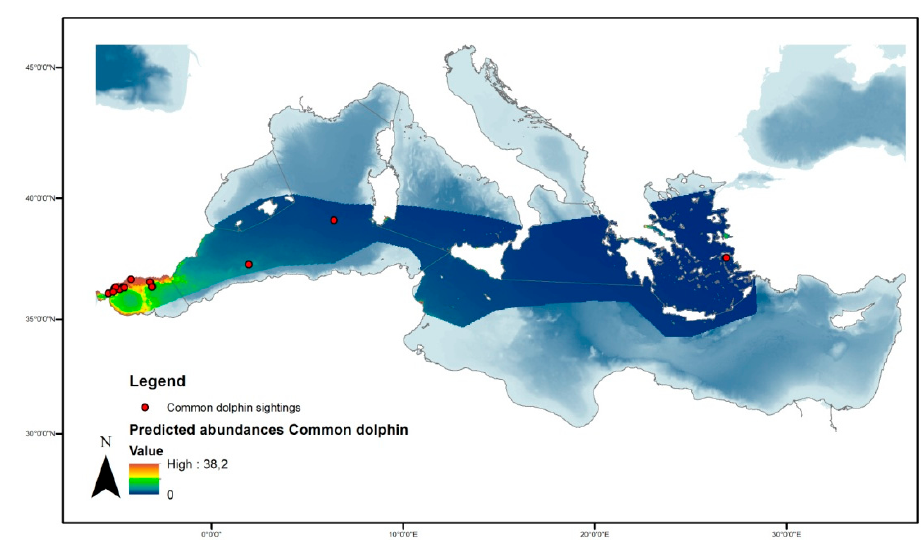
Figure 10. Spatial prediction of abundance for common dolphins per cell in the studied area.